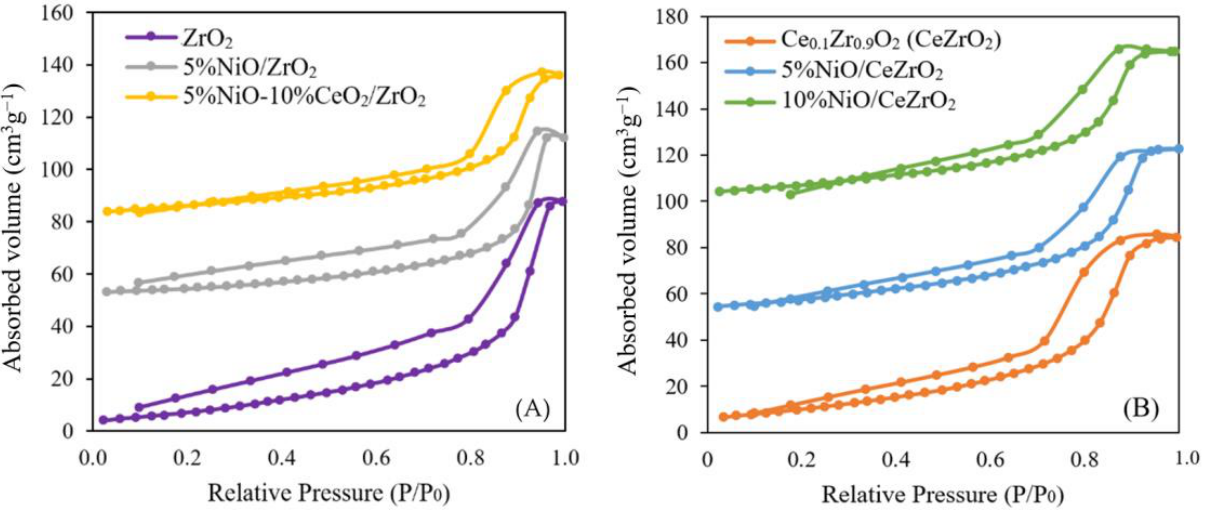
Figure 2. Nitrogen adsorption – desorption of catalyst: ( A ) ZrO 2 -supported NiO catalyst and ( B ) CeZrO 2 -supported NiO catalyst.